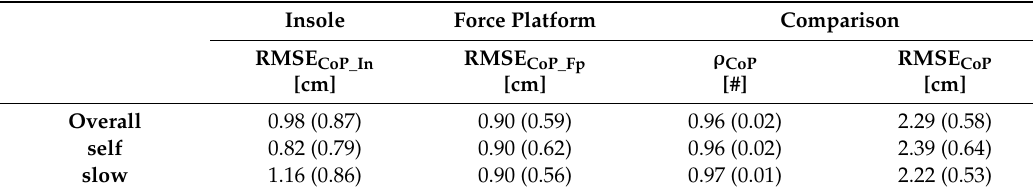
Table 3. Median (iqr) values for the antero-posterior coordinate of the Center of Pressure (CoP AP )